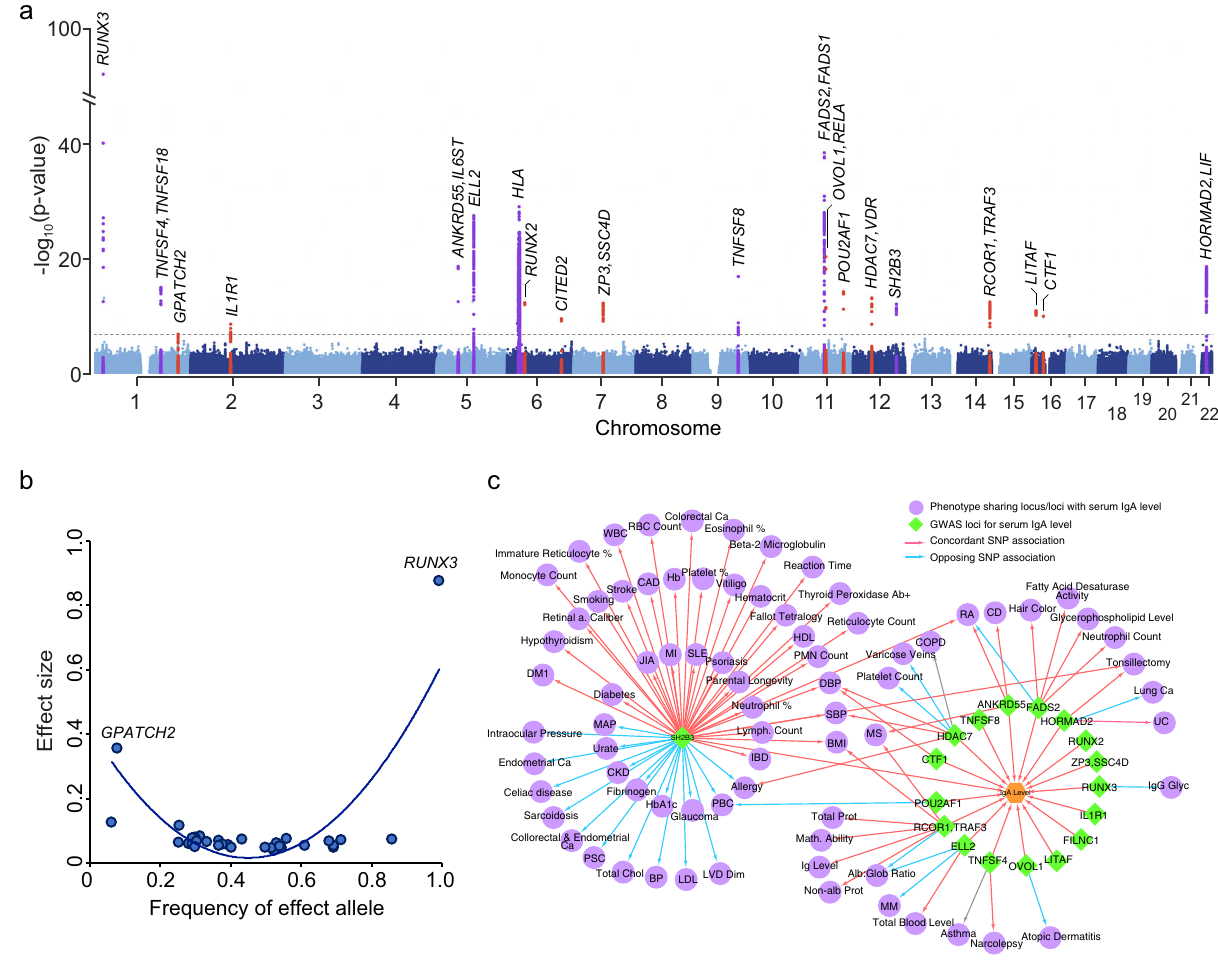
Fig. 2 | Trans-ethnic meta-analyses across all cohorts identi fi ed 20 genome- widesigni fi cantloci.a Manhattanplotdepictingatotalof11novelloci(red)aswell as 9 known loci (purple) identi fi ed in the meta-analysis; the dotted horizontal line indicates a genome-wide signi fi cance threshold ( P = 5 × 10 − 8 ); the y -axis depicts -log10(P-value) for the fi xed effects meta-analysis (two-sided, unadjusted), and is truncated to accommodate large peak at RUNX3 locus. b Correlation between